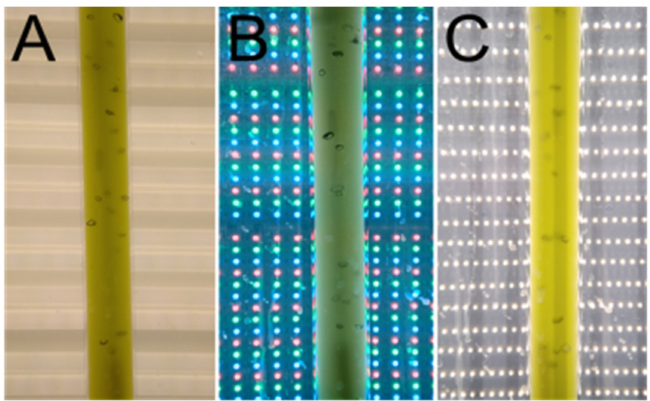
Figure 1. Light sources used for the cultivation. ( A ) Fluorescent lamps, ( B ) RGB LEDs, ( C ) white